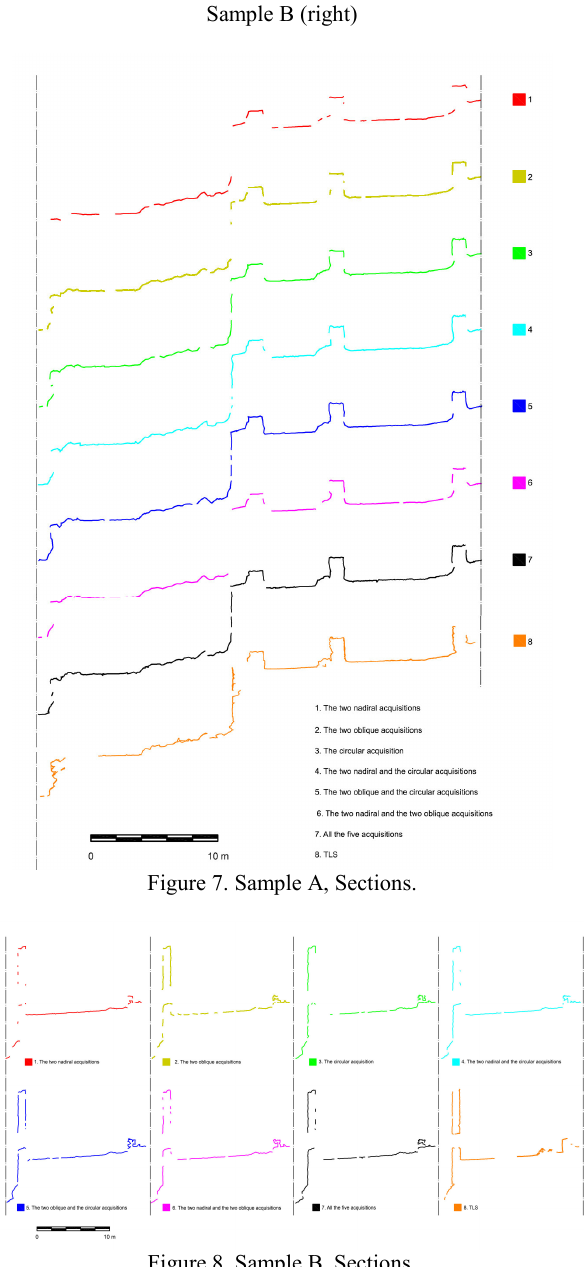
Figure 8. Sample B,